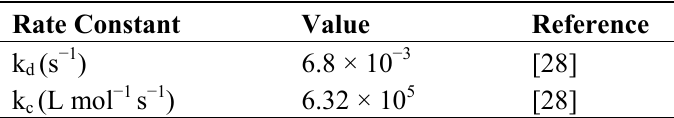
Table 5. Rate constants concerning reversible deactivation of propagating chains of styrene with nitroxide BIPNO at 123 °C.